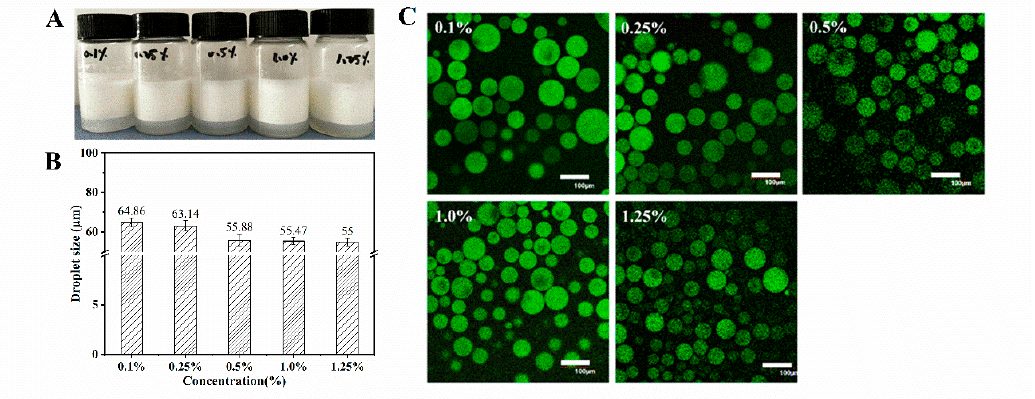
Figure 4. Microstructure of WPI fibrils stabilized Pickering emulsions. ( A ) Appearance, ( B ) average droplet size, and ( C ) confocal microscopic images of Pickering emulsion with different fibrils concentrations (0.1 wt.%–1.25 wt.%) at pH 2.0. The scale bar was 100 μ m.